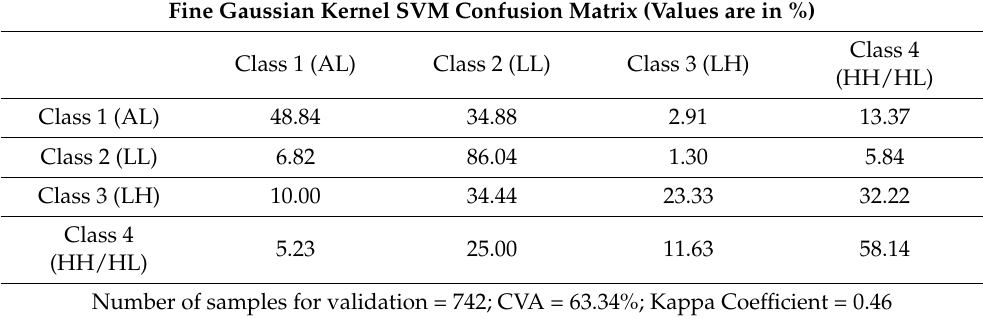
Table 8. Confusion matrices that were obtained during the independent validation phase. Fine Gaussian Kernel SVM Confusion Matrix (Values are in